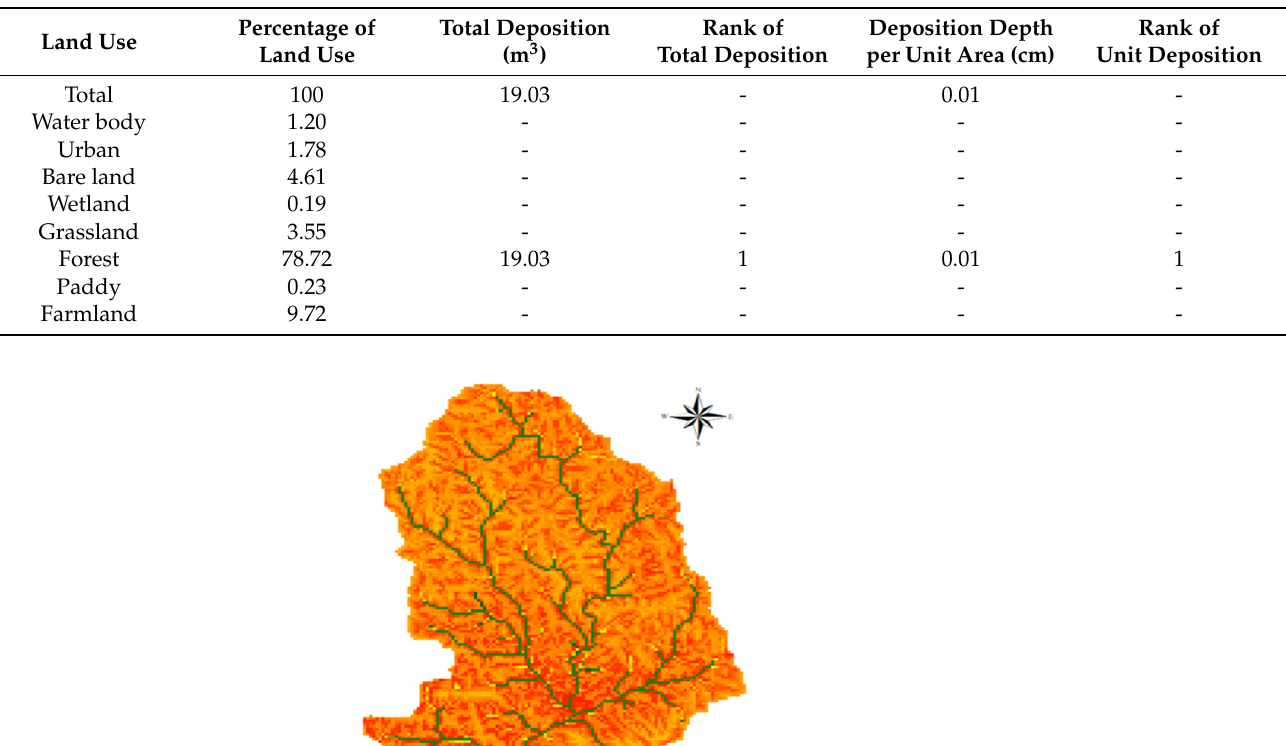
Table 4. Results of deposition by land use (R-SSEM).